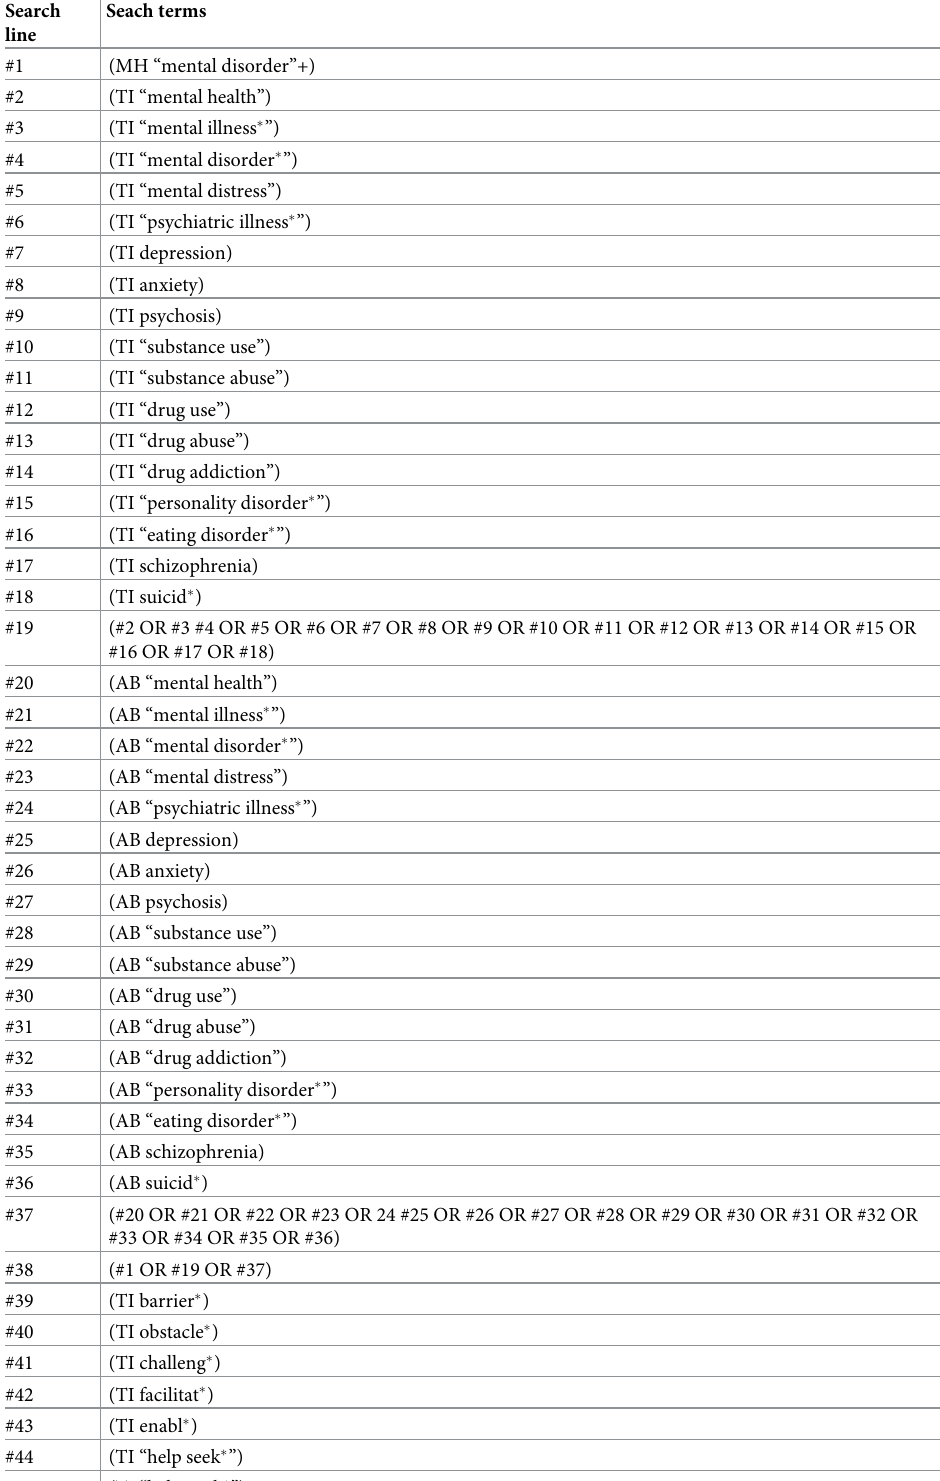
Table 2. Indicative search strategy for medline complete via